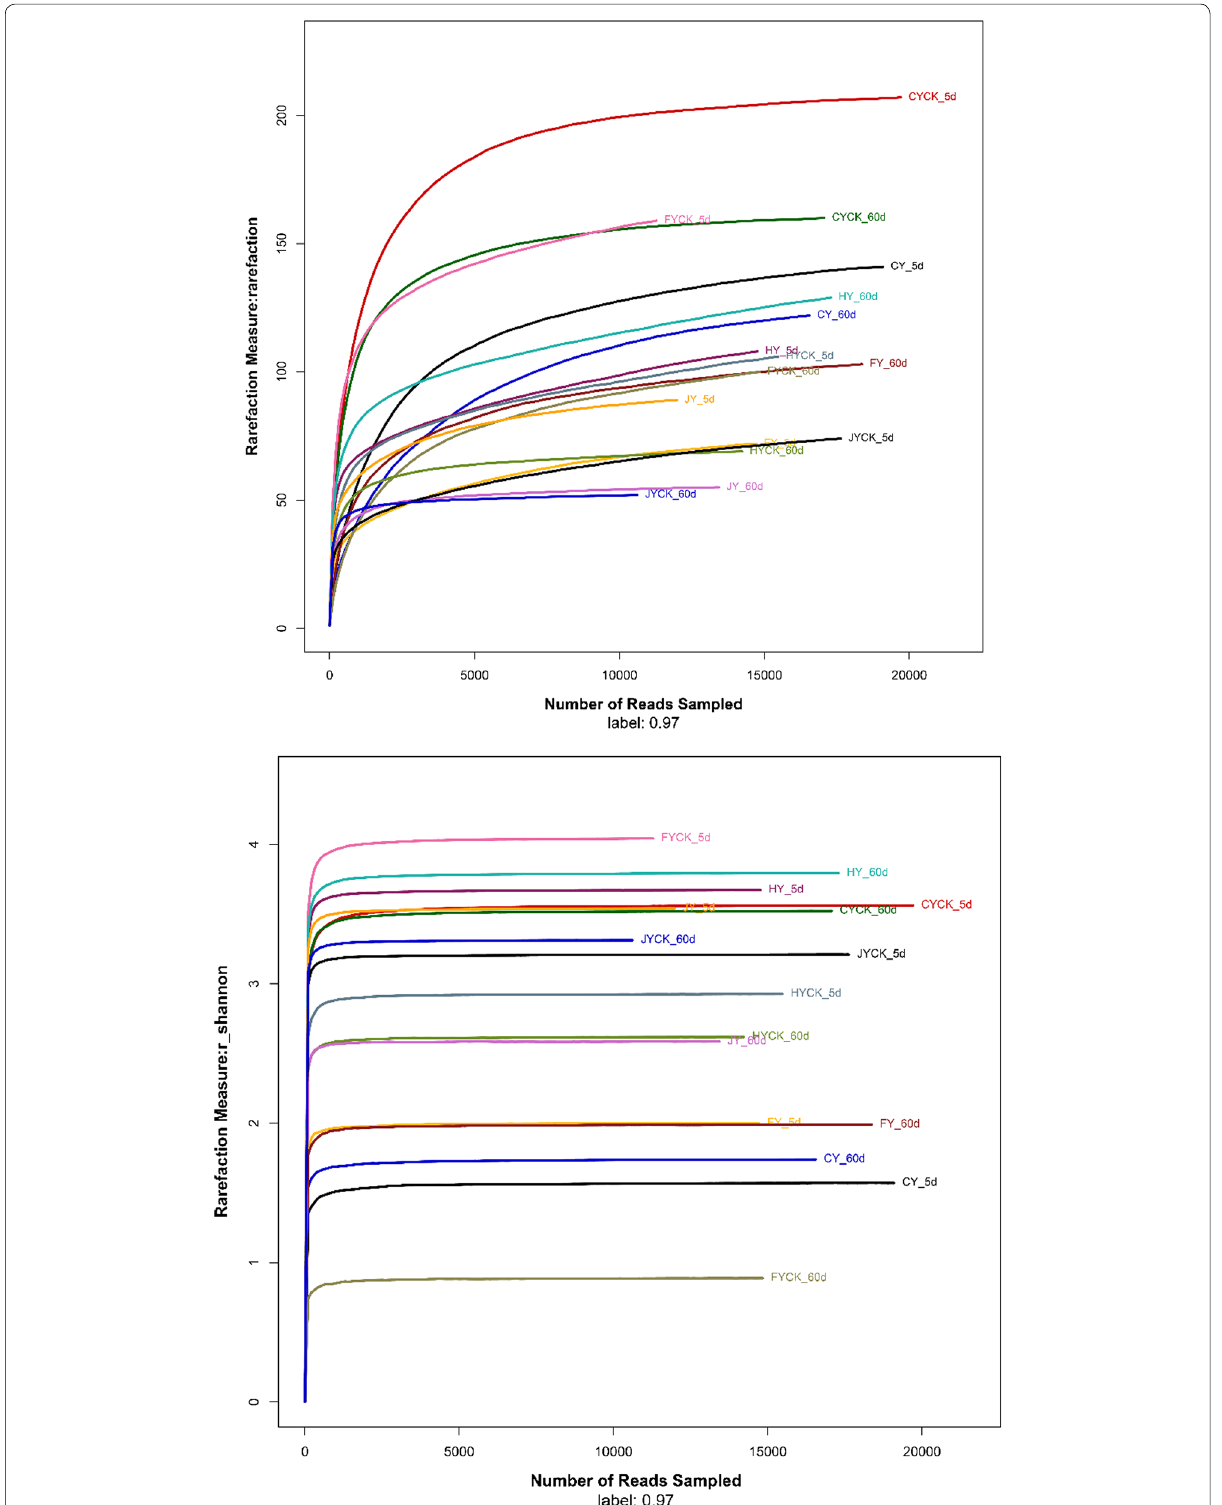
Fig. 2 Rarefaction curves ( a ) and Shannon–Wiener curves ( b ) (CYCK: CK of soil C; CY: soil C; FY: soil F; FYCK: CK of soil F; HY: soil H; HYCK: CK of soil H; JY: soil J; JYCK: CK of soil